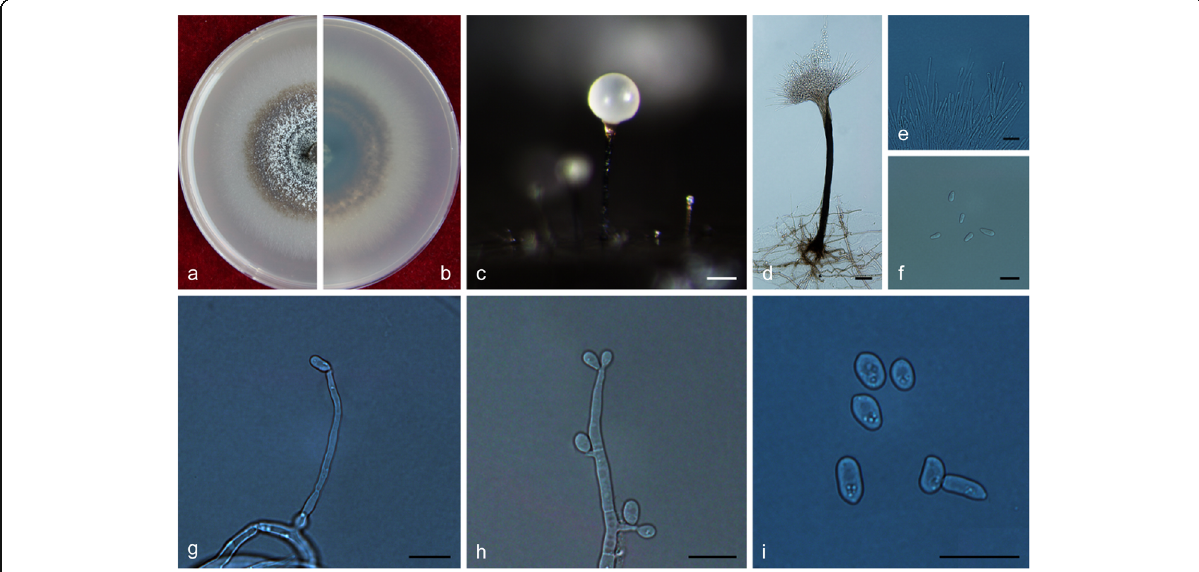
Fig. 15 Morphological characteristics of Ophiostoma multisynnematum sp. nov. (CFCC 52677, Taxon 5). a – b. Ten-day-old cultures on 2% MEA; c – d. Pesotum-like asexual morph; e – f. Conidiogenous cells of pesotum-like asexual morph and conidia; g – i. Hyalorhinocladiella-like asexual morph: conidiogenous cells and conidia. Scale bars: c = 50 μ m; d = 20 μ m; e – i = 10 μ